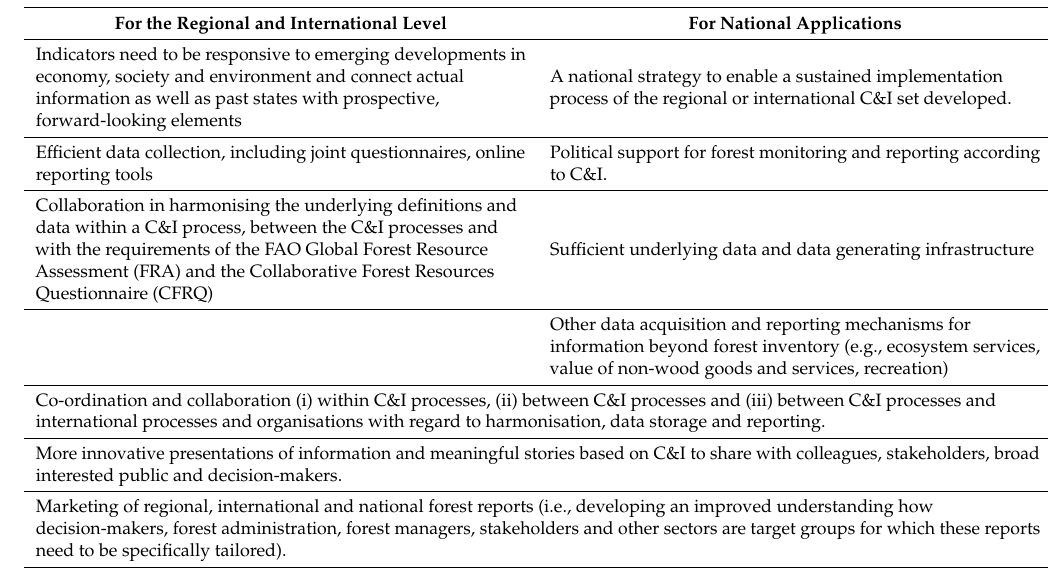
Table 4. Success factors for C&I implementation.